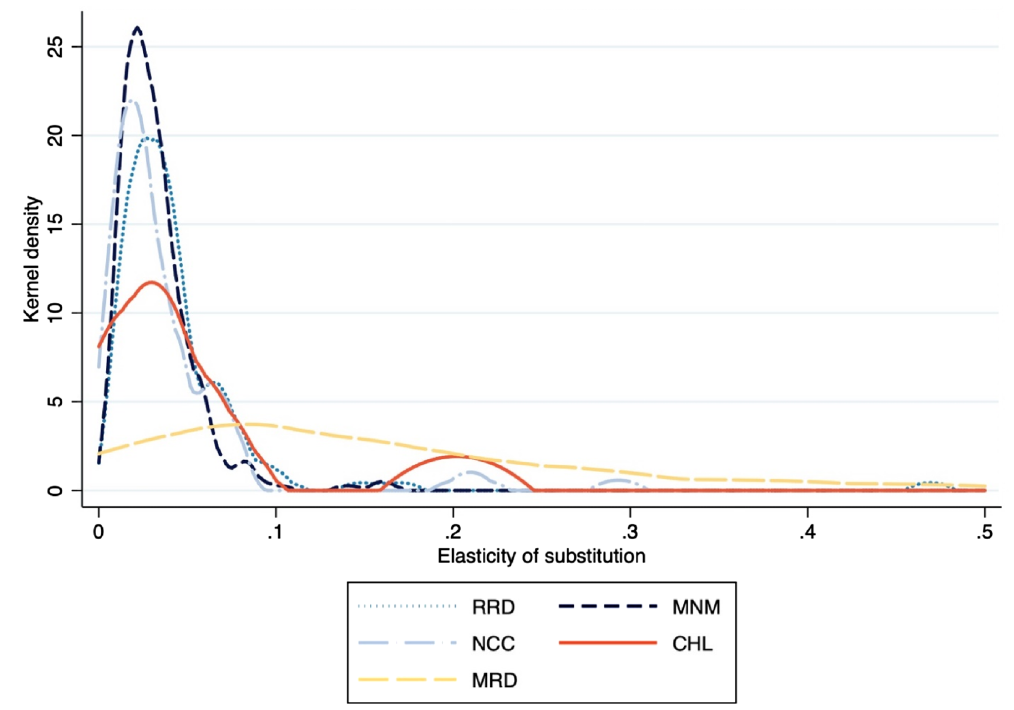
Figure 5. Kernel probability densities of Morishima substitution elasticity in rice production, by region.